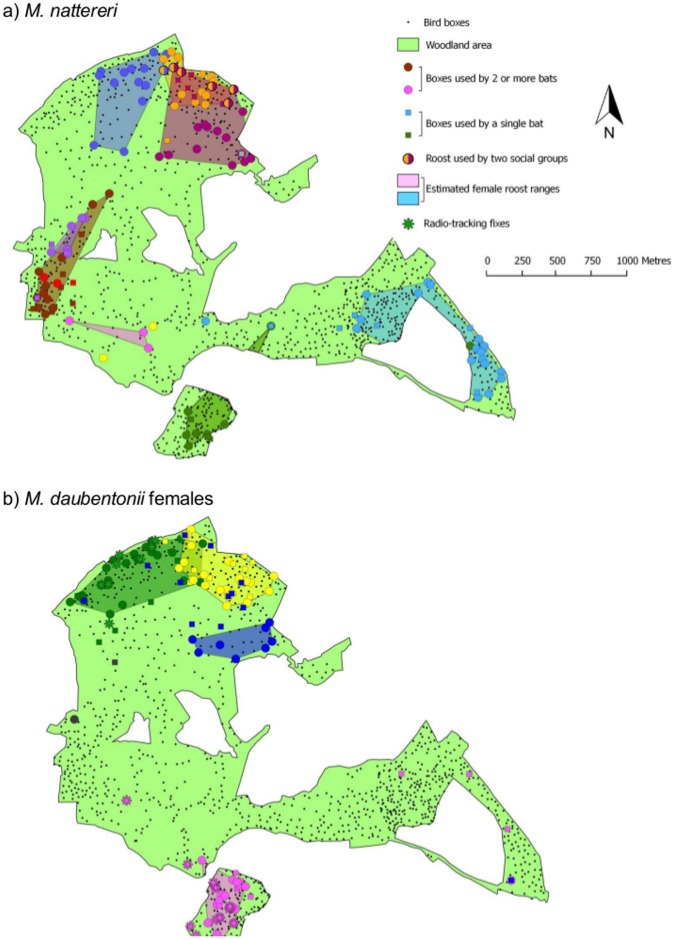
Distribution of a) M. nattereri both sexes and b) female M. daubentonii social groups in Wytham Woods.Roosts used by bats, and home range estimates are coloured according to social group - colours are comparable to Figure 2, panels a) and c) – symbols indicate colony size and roosts identified by radio-tracking. Roost home ranges are estimated using 100% minimum convex polygons (MCPs). MCPs exclude roosts occupied by a single individual (M. nattereri, n = 42; M. daubentonii, n = 44) or separated by over 1 km from a roost of the same social group (n = 1 for each species). Four adult female M. daubentonii were radio-tracked; two from each of two social groups. The daytime roosts (including trees) used by these individuals are indicated by asterisks and are coloured according to the social group to which they belonged.